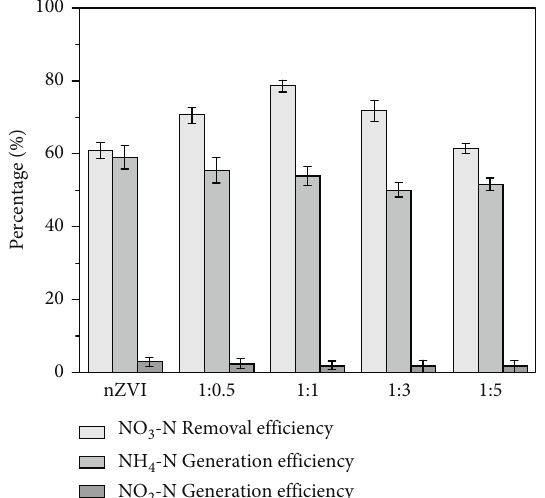
Figure 5: E ff ect of nZVI and ATP mass ration on NO rate. ATP: attapulgite; nZVI: nano-zero-valent iron (initial NO concentration = 30 mg/L, adsorbent = 1 : 5 g/L, pH = 7 , reaction temperature = 25 ° C, and contacttime = 150 min).